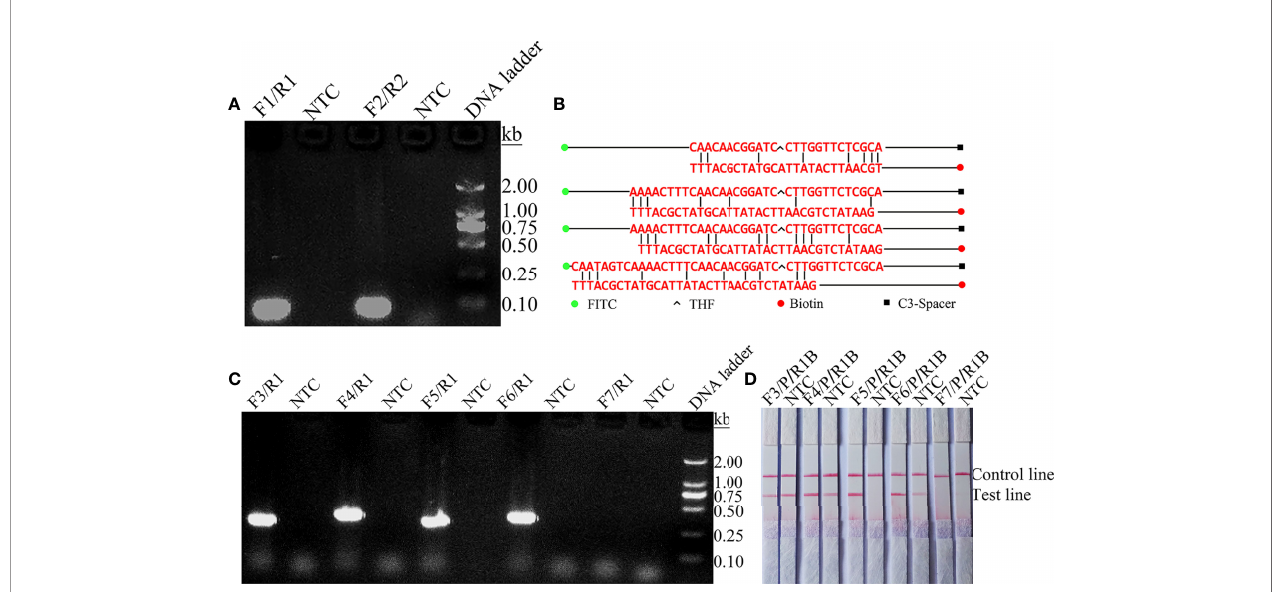
FIGURE 1 | Screening of primer-probe combinations. (A) RPA results for two different primer sets of the ITS2 gene. Primer sets are indicated at the top of each lane. No-template control (NTC) was used in the reactions. All reactions were performed at 37°C for 30 min. Images are representative of three independent experiments. (B) Pairwise analysis and sequence modi fi cation of the primer-probe sets used to detect the ITS2 gene using Primer Premier 5 software. The associated DNA base substitutions of the probes and primers. The DNA strands are shown as horizontal lines and the matching bases are indicated by vertical lines. Molecular markers are listed under Figure (B) . (C) Agarose gel showing primers for RPA ampli fi cation using C. tropicalis genomic DNA as a template. The names of the primer pairs are indicated at the top of each lane. NTC indicates the no-template control for the respective primer pair. The band size of the DNA ladder is shown on the right. (D) Validity of primer-probe sets for the RPA-LFS assay. The name of each primer set is shown at the top of each lane, and NTC indicates the no template control for the respective primer pair. The positions of the test and control lines are shown on the right. All reactions were performed at 37°C for 30 min. Images are representative of three independent